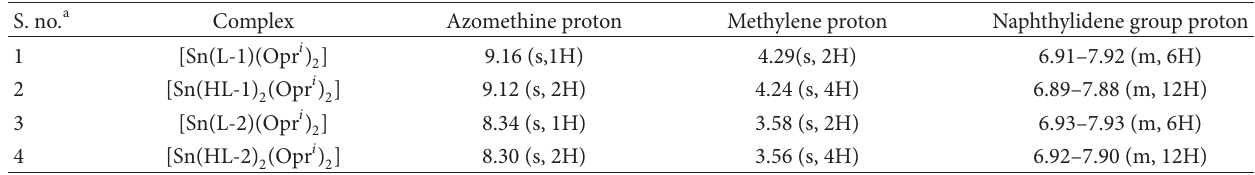
T 3: NMR spectra of complexes (in